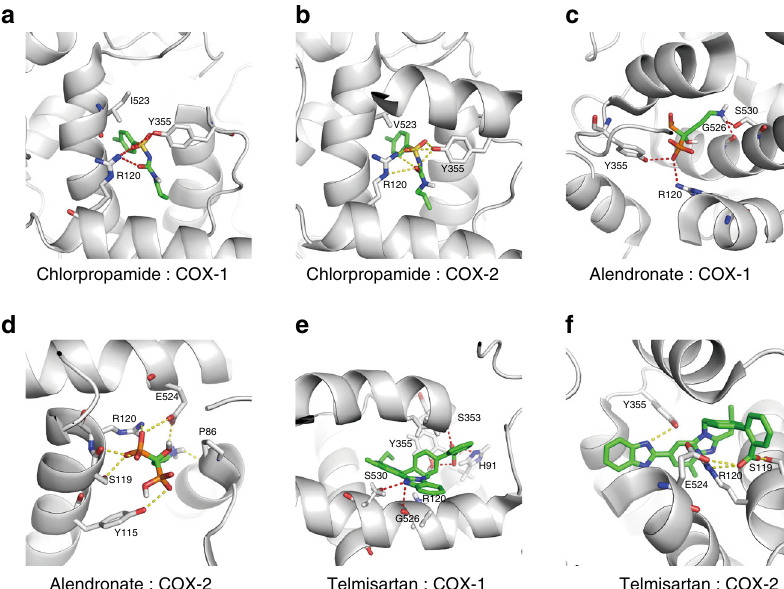
Fig. 5 The docked poses for the predicted interactions between three drugs (i.e., chlorpropamide, alendronate and telmisartan) and the COX proteins (i.e., COX-1 and COX-2). a Chlorpropamide vs. COX-1; b Chlorpropamide vs. COX-2; c Alendronate vs. COX-1; d Alendronate vs. COX-2; e Telmisartan vs. COX-1; f Telmisartan vs. COX-2. The protein structures of COX-1 and COX-2 were downloaded from the Protein Data Bank (PDB IDs 3kk6 and 3qmo for COX-1 and COX-2, respectively). The structures of the small molecules were obtained from the ZINC 61 . The docking program Autodock 3 was used for the docking modeling. Hydrogen bonds were computed by PyMOL 70 and represented by the red and yellow dashed lines in COX-1 and COX-2,